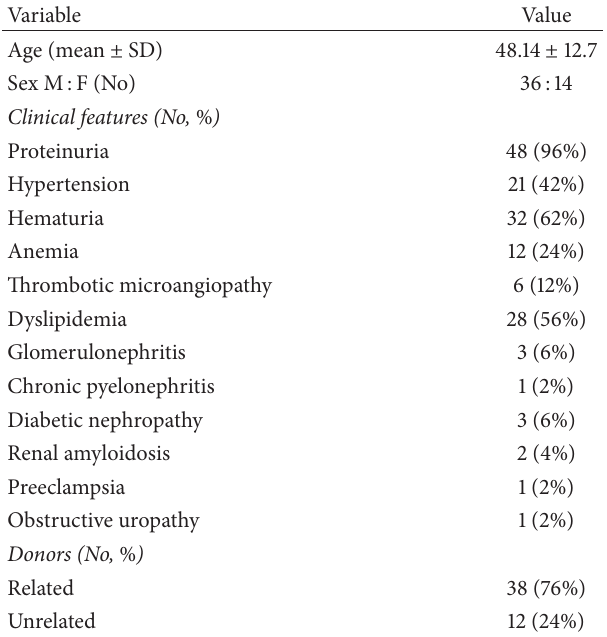
Table 1: Demographic and clinical features of the nephropathic patients.